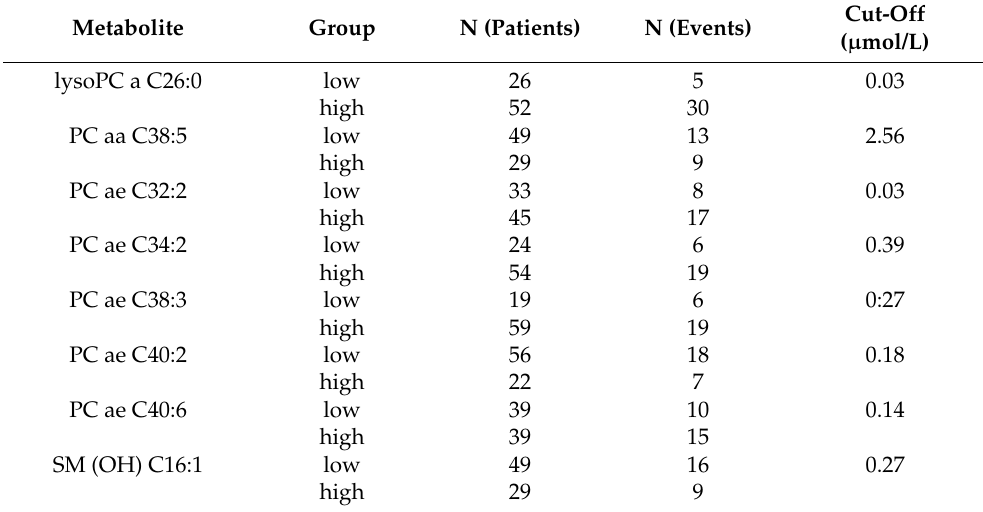
Table 4. Cut-off for categories of high or low biomarker concentration in patients with breast cancer.